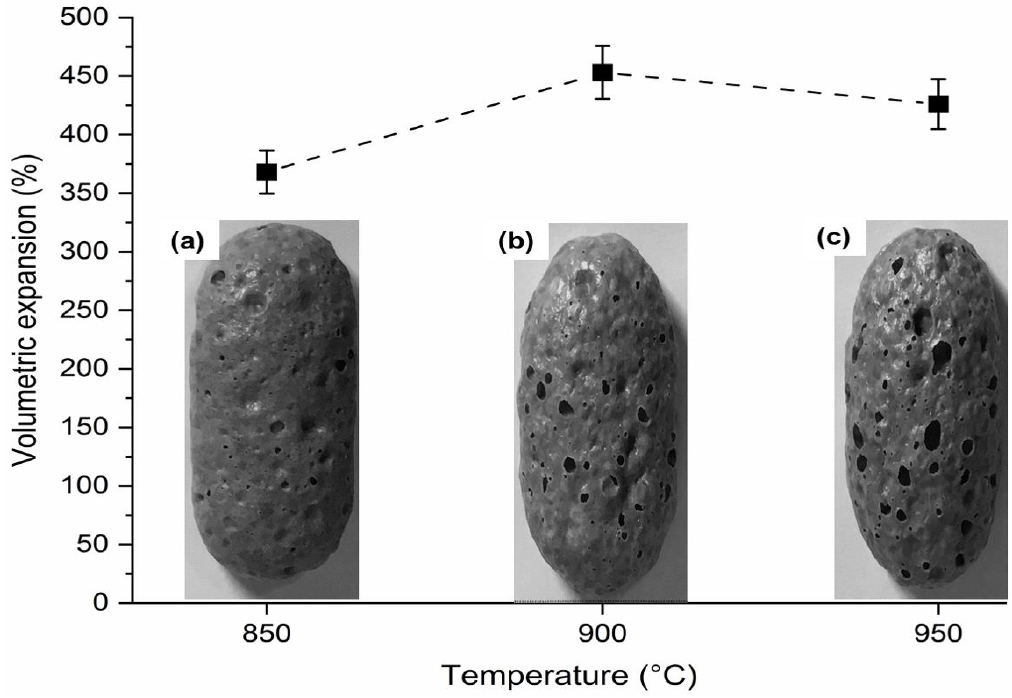
Figure 5. Geometric shape and volumetric expansion of the glass foams sintered at ( a ) 850 °C, ( b ) 900 °C and ( c ) 950 °C.